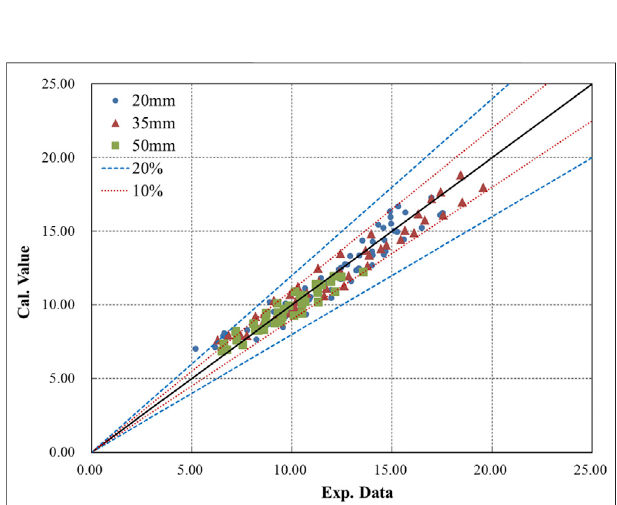
FIGURE10 | Deviationof Eq. 30 with arelative roughness of0.004 from the NCCL experimental